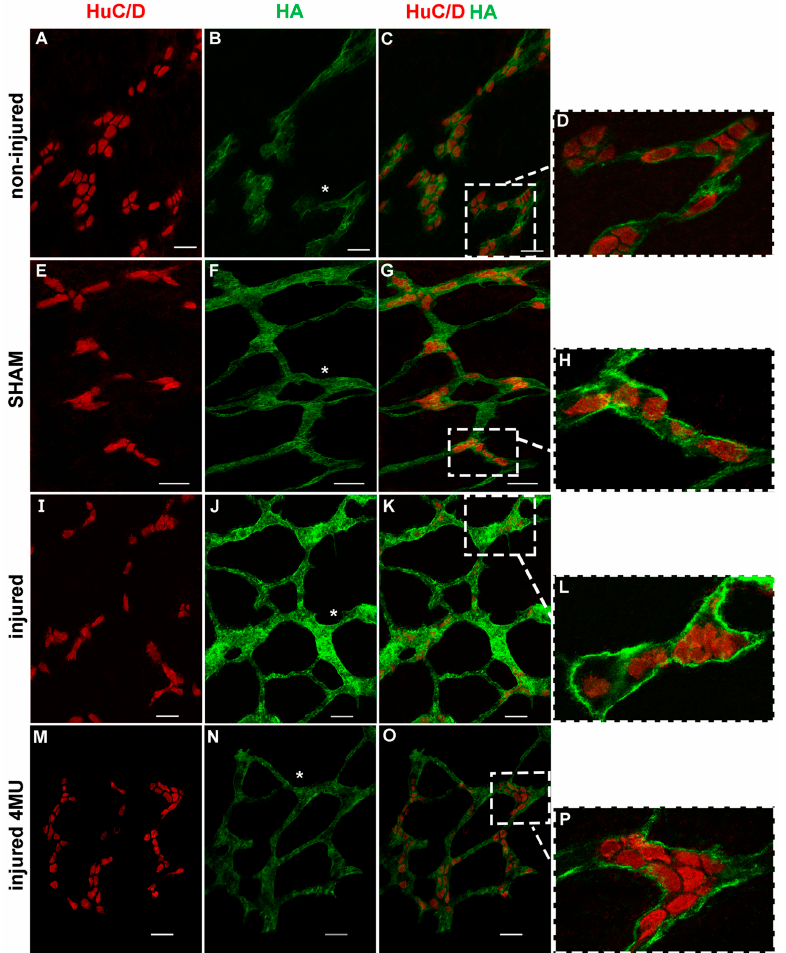
Figure 4. HA immunofluorescence staining increases in rat small intestine submucosal plexus after IRI injury and is reduced after MU treatment. ( A – P ) Confocal microphotographs of HA staining in the rat small intestine submucosal plexus in non-injured group ( A – C ); ( D ) median section at higher magnification of panel ( C ), sham-operated group ( E – G ); ( H ) median section at higher magnification of panel ( G ), untreated injured group ( I – K ); ( L ) median section at higher magnification of panel ( K ) and in the 4-MU-treated injured group (( M – P ); ( R ) median section at higher magnification of panel ( Q ) groups)). In all groups, HA stained the surface of submucosal plexus and interconnecting fibers (*) (panels ( B , F , J , N )). In submucosal ganglia median sections, HA immunofluorescence was prevalently found in the perineuronal space and in the neuron soma (panels ( D , H , L , P )), as demonstrated by double-staining with the pan-neuronal marker, HuC/D. Microphotographs were obtained with the same gain resolution. Scale bar = 50 µ m. N = 5